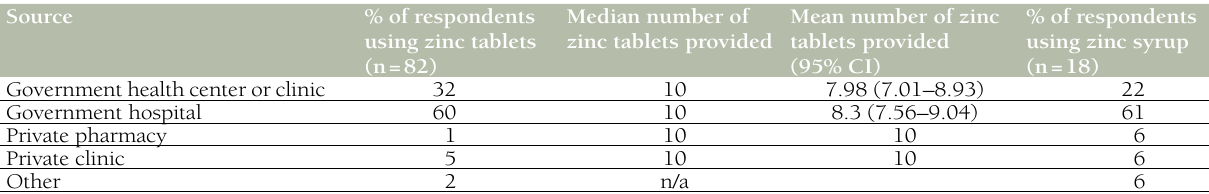
Table 4. Source of zinc and median number of tablets provided